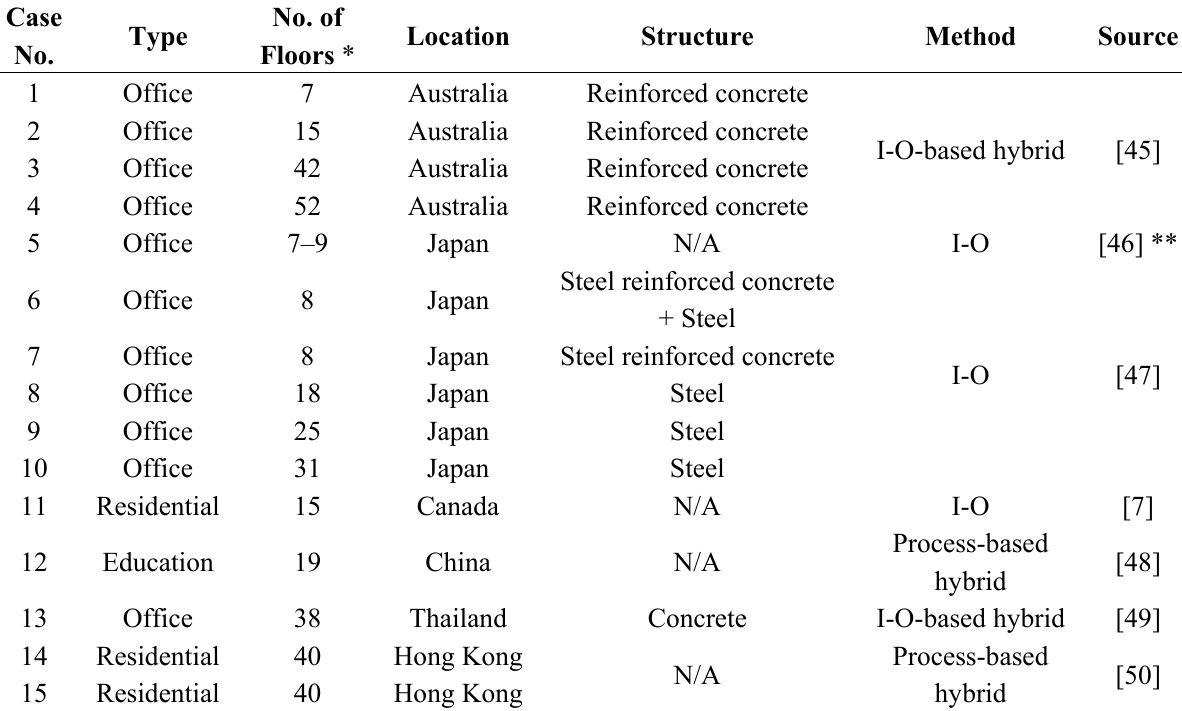
Table 5. Overview of literature on embodied energy (EE) of high-rise